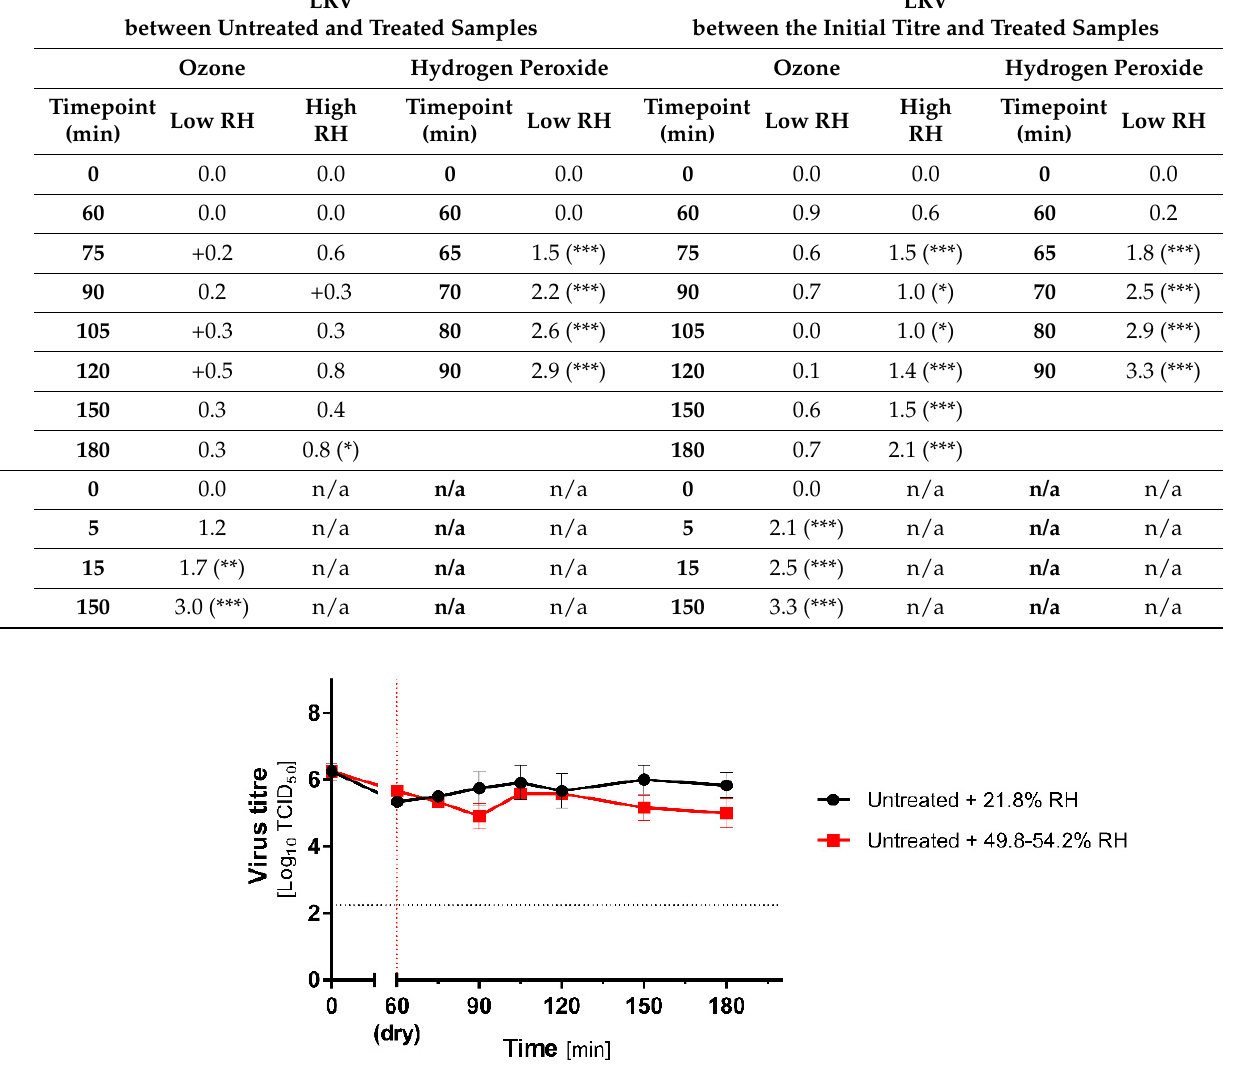
Table 2. Reduction in the MHV titres after fumigation. The results are presented as LRV and denote the reduction in the viral titre in treated samples, as compared with the initial levels. Plus signs represent samples, where an untreated sample showed a lower titre than a treated one. Asterisks represent statistical significance: (*) p < 0.05; (**) p < 0.01; (***) p < 0.001; non-significant reduction is not marked. The measured values of RH were as follows: 21.8% RH is marked as low, and 48.8–54.2% RH is marked as high RH.